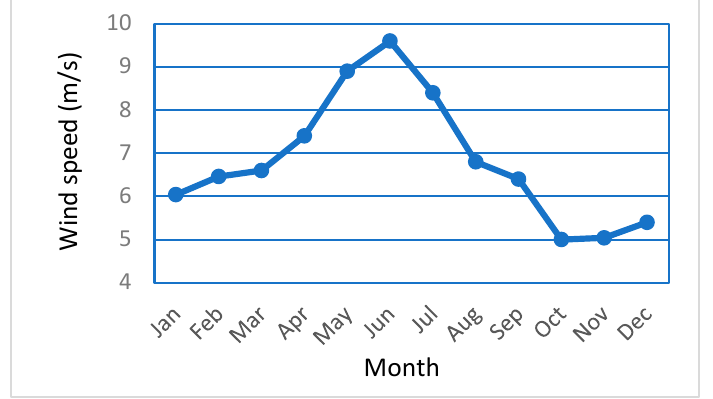
Figure 9. Monthly mean wind speed at site.